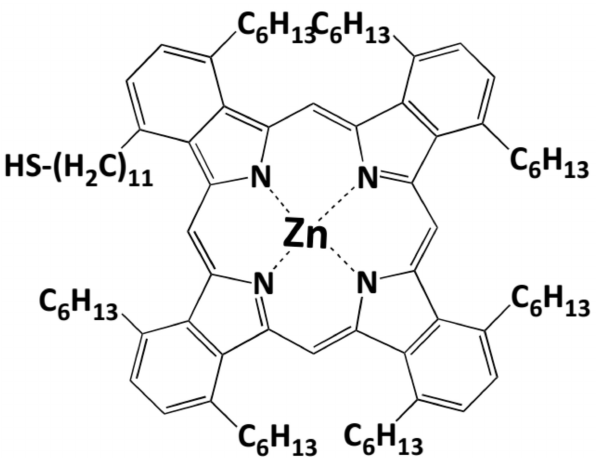
Figure 18. Phthalocyanin Zinc (II) complex for photodynamic treatment coating Au NPs. Reproduced by reference permission [146], ACS,